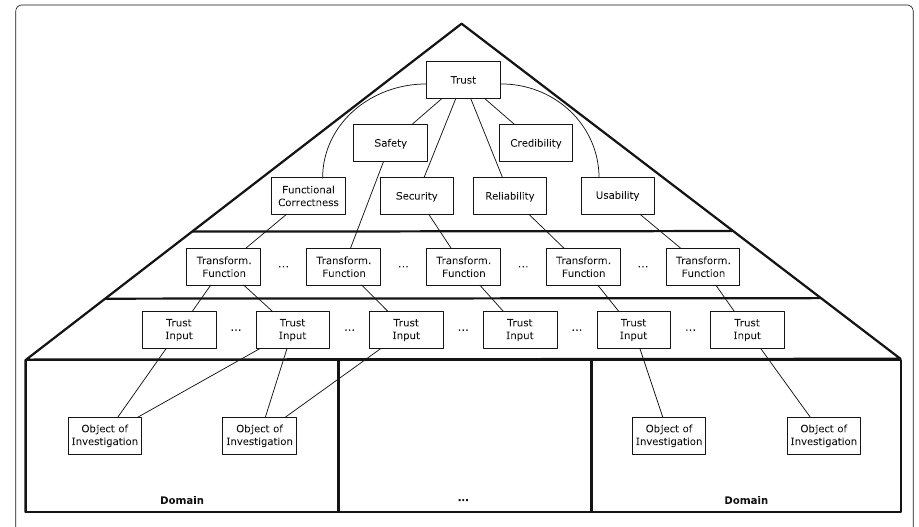
Fig. 1 The trust assessment